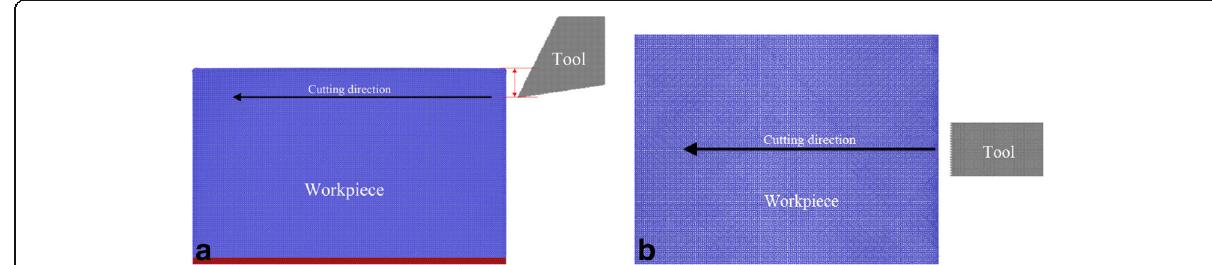
Fig. 1 MD model of diamond cutting of cerium; (color online) MD model of diamond cutting of cerium. a Front view and b top view . Red and blue colors stand for bottom and mobile Ce atoms, and gray color indicates C